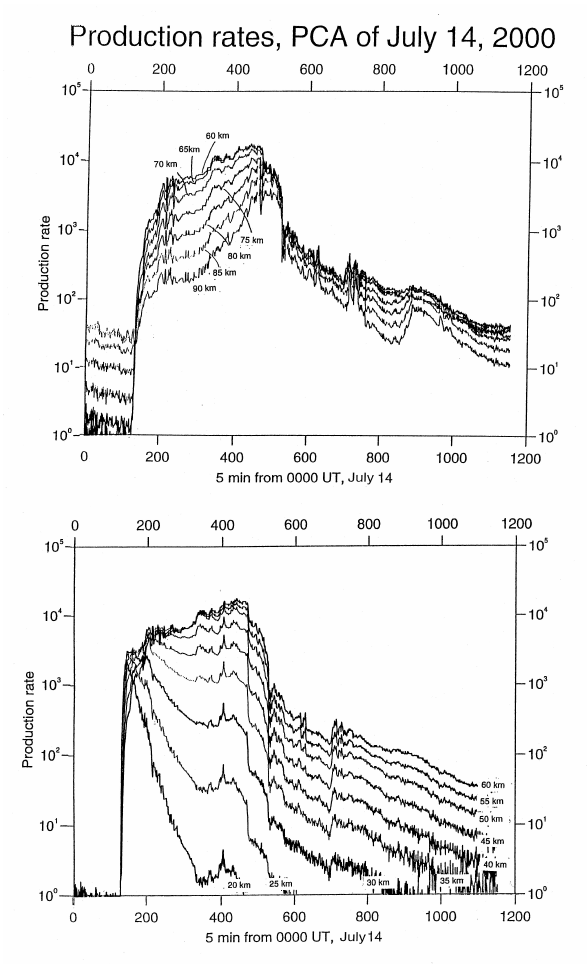
Fig. 5. Ion production rates computed for heights from 20 to 90km during the proton event of July 2000. The curves are displayed in two panels for